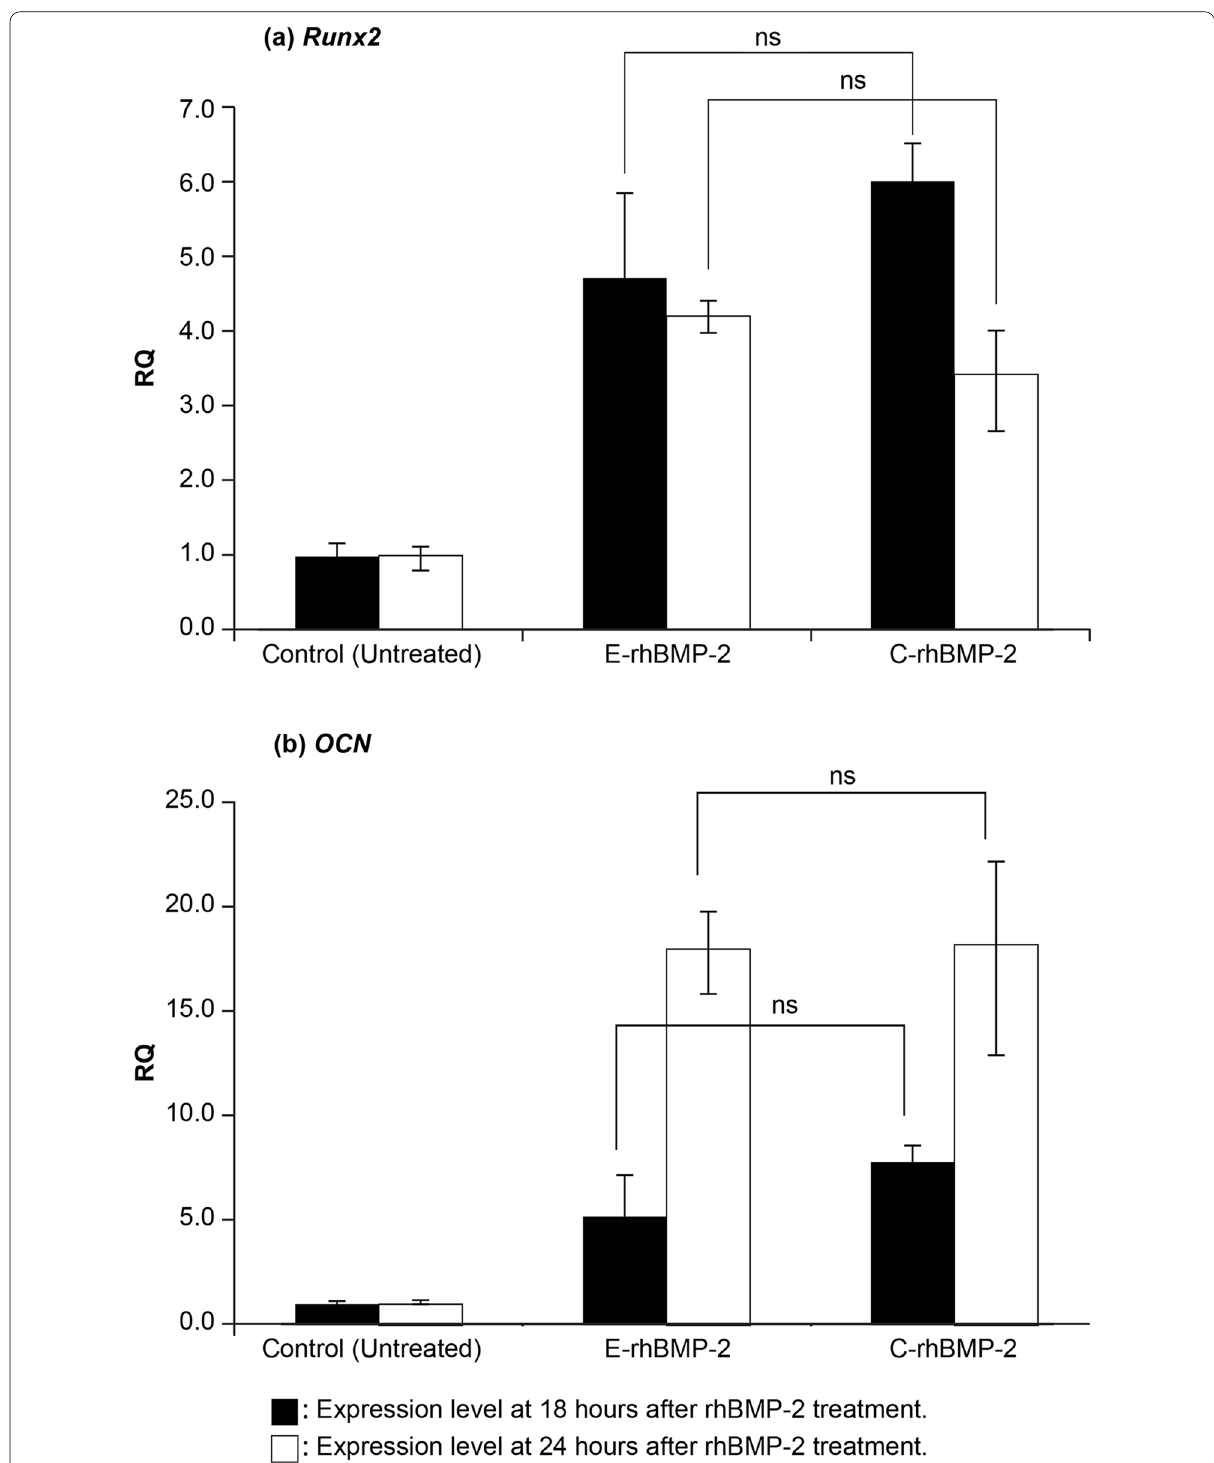
Fig. 2 Relative mRNA expression levels of Runx2 and OCN in rhBMP‑2‑treated C2C12 cells at 18 h and 24 h. a Relative expression level of Runx2 , b relative expression level of